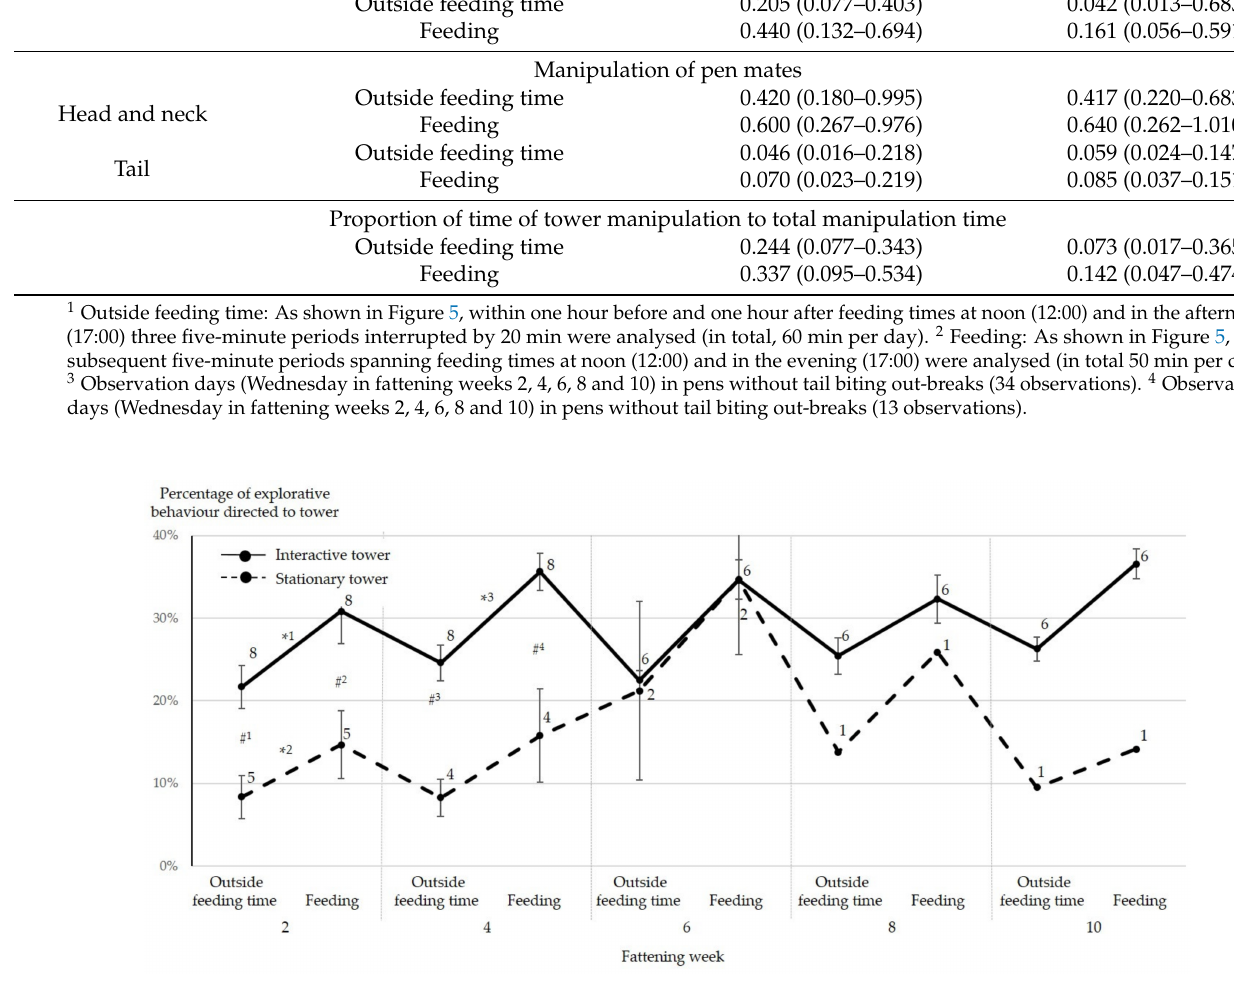
Figure 7. Percentage of time spent for manipulation of the tower in the total manipulation time in the control and experimental group. Data of pens in the different groups are presented as means ± SEM in different weeks of fattening outside feeding times and during feeding. Numbers of evaluated pens are depicted next to the marks. Several pens were removed from data analysis due to severe tail biting outbreaks which required interventions such as providing additional straw and separating the pen. * significant difference between time points within group, # significant difference between groups at respective time point. * 1 p < 0.001, * 2 p = 0.017, * 3 p = 0.001, # 1 p = 0.029, # 2 p = 0.011, # 3 p = 0.004, # 4 p < 0.001 (Pairwise multiple comparison procedure, Holm–Sidak